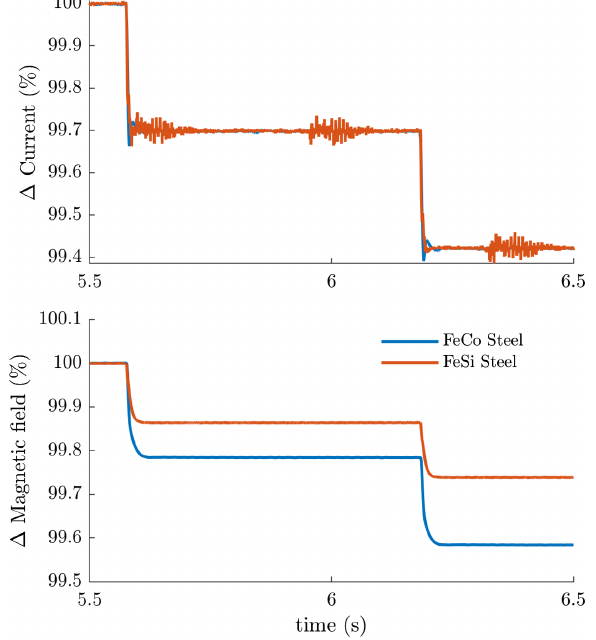
FIG. 20. High current step. Top: current normalized and bottom: variation of the field normalized.